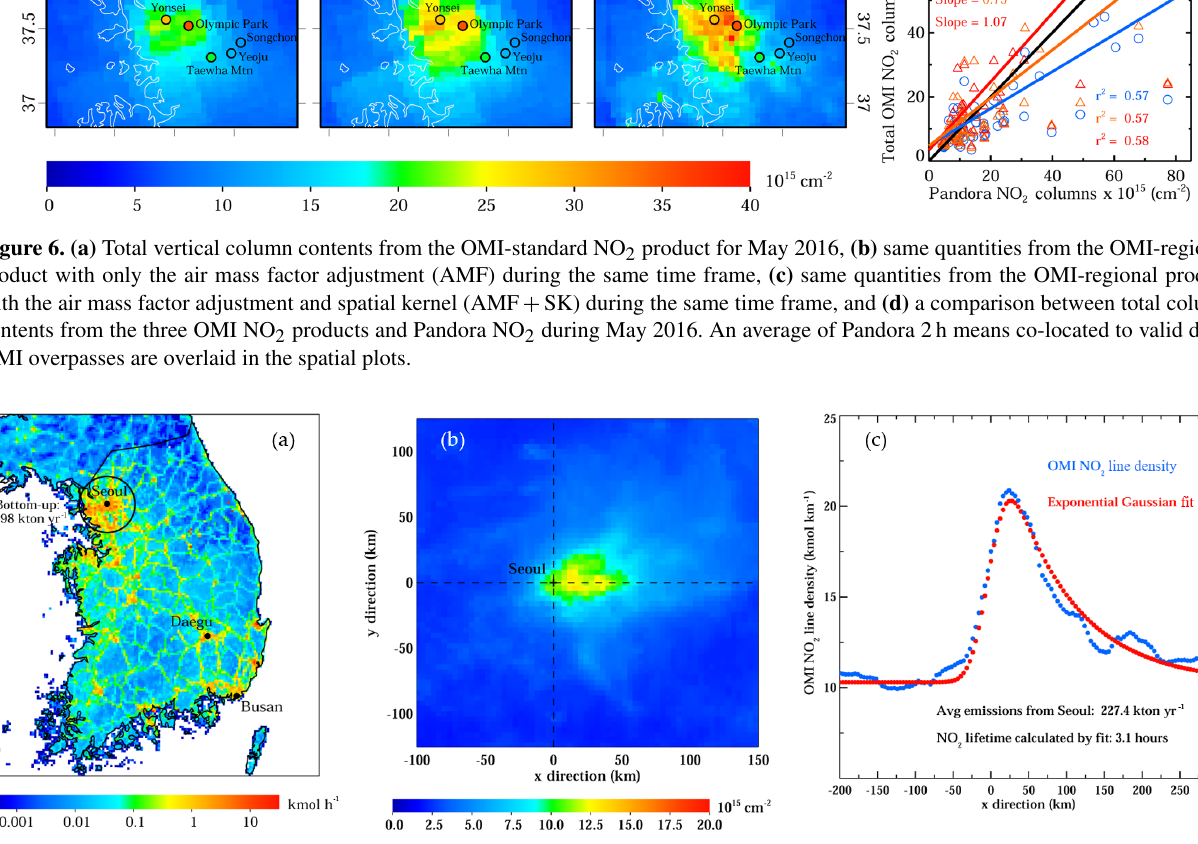
Figure 7. (a) Bottom-up NO x emissions inventory compiled for the KORUS-AQ field campaign, (b) the oversampled NO 2 plume rotated based on wind direction for Seoul, South Korea, from WRF-Chem (4km × 4km) for May 2016, and (c) NO 2 line densities integrating over the 240km across-plume width ( − 120 to 120km along the y axis) and the corresponding EMG fit. NO x emissions estimates are shown in units of ktyr − 1 NO 2 equivalent and represent the midafternoon emissions